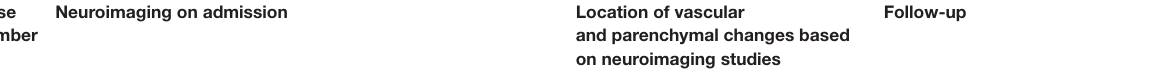
CT: Right fronto-temperal mixed signal density, left parieto-occipital hemorrhagic infarction. HR-MRBTI: Strand-like high intense signal in right fronto-parietal superficial cortical vein.